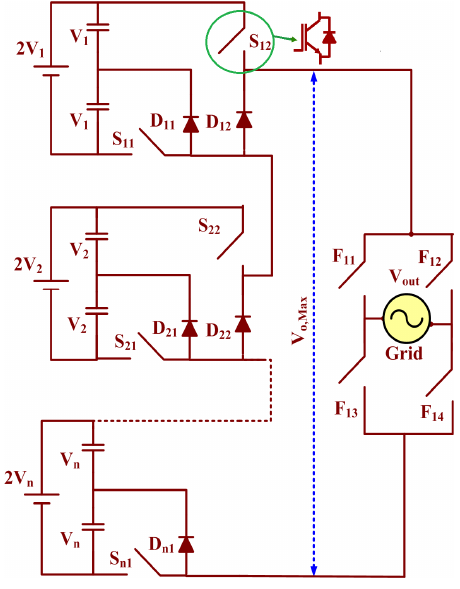
Figure 2. Proposed SDHB multilevel inverter topology. Table 2. Switching Sequence of the Proposed Symmetric